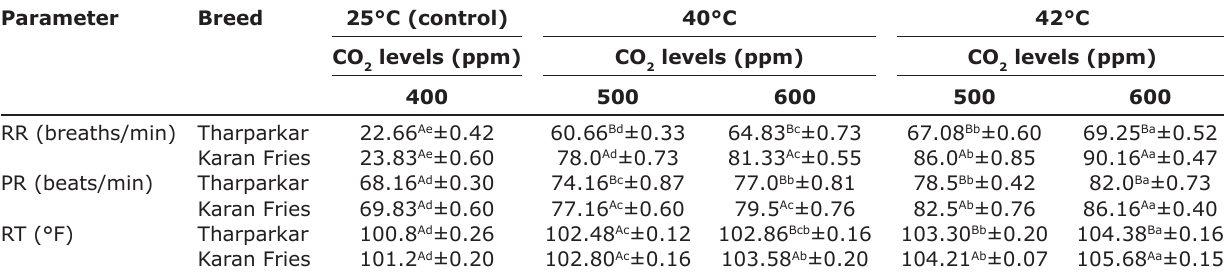
levels on physiological responses of Tharparkar and Karan Fries heifers. 2